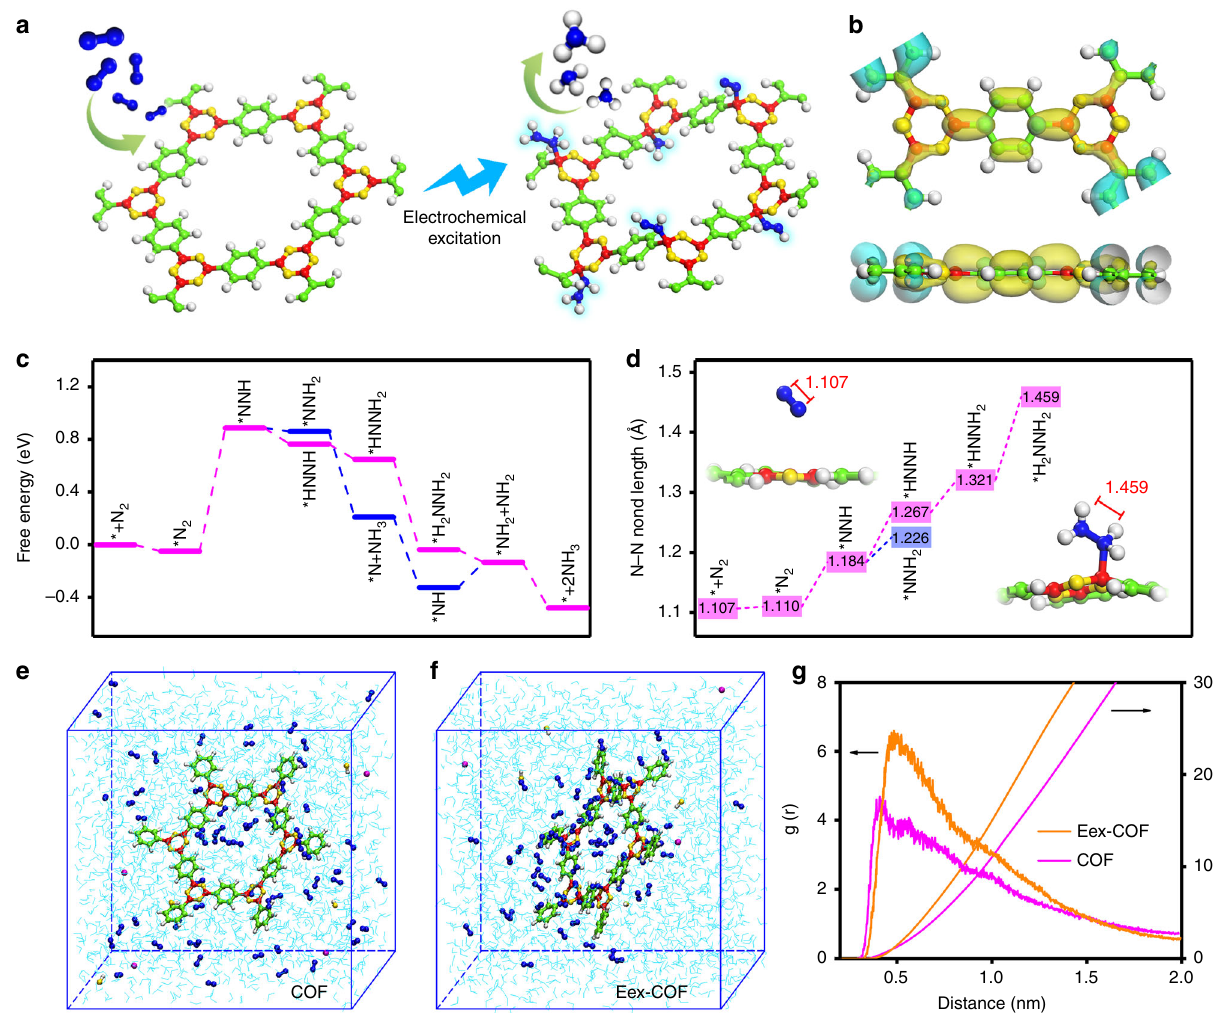
Fig. 1 Computational studies. a Schematic illustration of the electrochemical excitation of COF. b The calculated charge distribution of COF. c Free energy diagrams and d changes of N – N bond length for ammonia synthesis. Molecular dynamics simulation snapshots of e COF and f Eex-COF. g Radial distribution function (RDF) and integrated RDF of nitrogen molecules around different models. The red, green, blue, yellow, and gray spheres represent B, C, N, O, and H atoms,